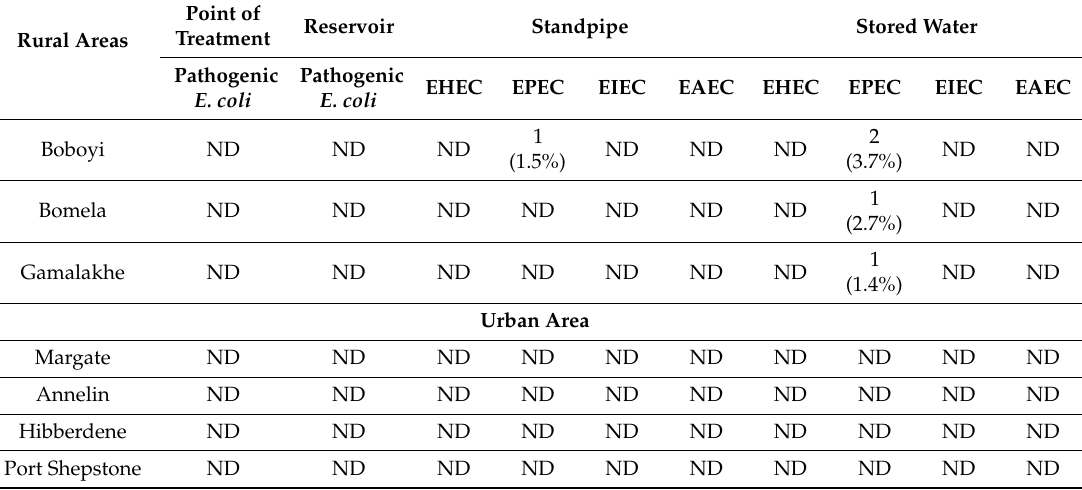
Table 7. The distribution of pathogenic strains of E. coli identified in drinking water collected from January 2008 to November 2009, and April 2015 from the Ugu District Municipality, KwaZulu-Natal Province, South Africa (N =